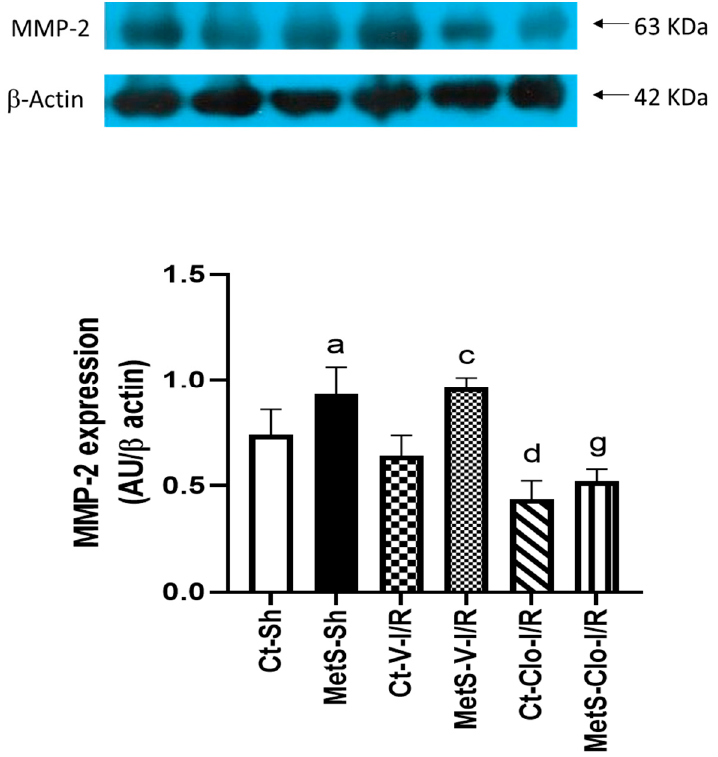
Figure 3. Effect of clofibrate treatment in the expression of MMP-2 in damaged ventricles from control and MetS rats. Expression was evaluated by Western blot in the myocardial ischemic area from sham (Sh), I/R-V, and I/R-Clo groups. Data represent mean ± SEM normalized to β -actin (n = 6 rats per group). a p < 0.0001 vs. Ct-Sh; c p < 0.0001 vs. Ct-V-I/R; d p < 0.0001 vs. Ct-V-I/R; g p < 0.0001 vs. MetS-V-I/R. Abbreviations: Ct = control; MetS = metabolic syndrome; Sh = sham-operated rats; V = vehicle; Clo = clofibrate.